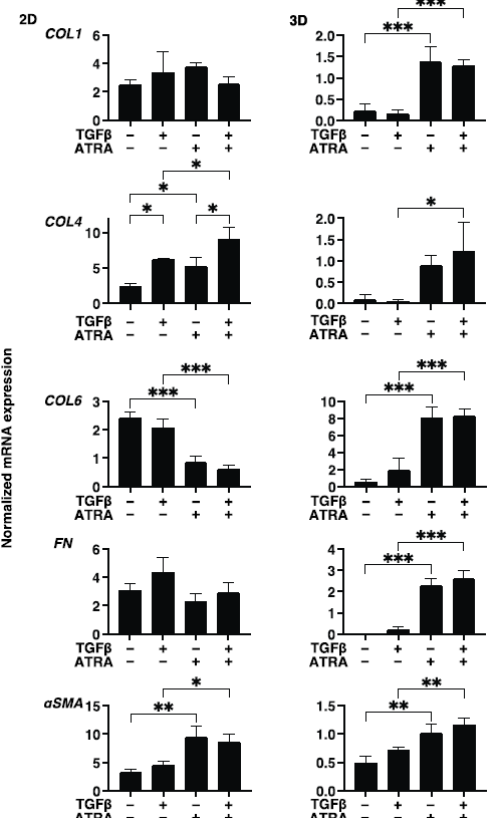
Figure 4. Effects of ATRA toward the gene expression of ECMs of the TGF- β 2 untreated or treated HconF cells. Two-dimensional and three-dimensional HconF cells untreated and treated with TGF- β 2 (TGF β , 5 ng/mL) were subjected to qPCR analysis in the presence or absence of 1 μ M ATRA and the mRNA expressions in ECMs, including COL1 , COL4 , COL6 , FN, and aSMA, were evaluated. All experiments were performed in triplicate using 3 different confluent 6-well dishes (2D) or 15 freshly prepared 3D HconF spheroids (3D) in each experimental condition. Data are expressed as the mean ± standard error of the mean (SEM). * p < 0.05, ** p < 0.01 and *** p < 0.005; ANOVA followed by a Tukey’s multiple comparison test.